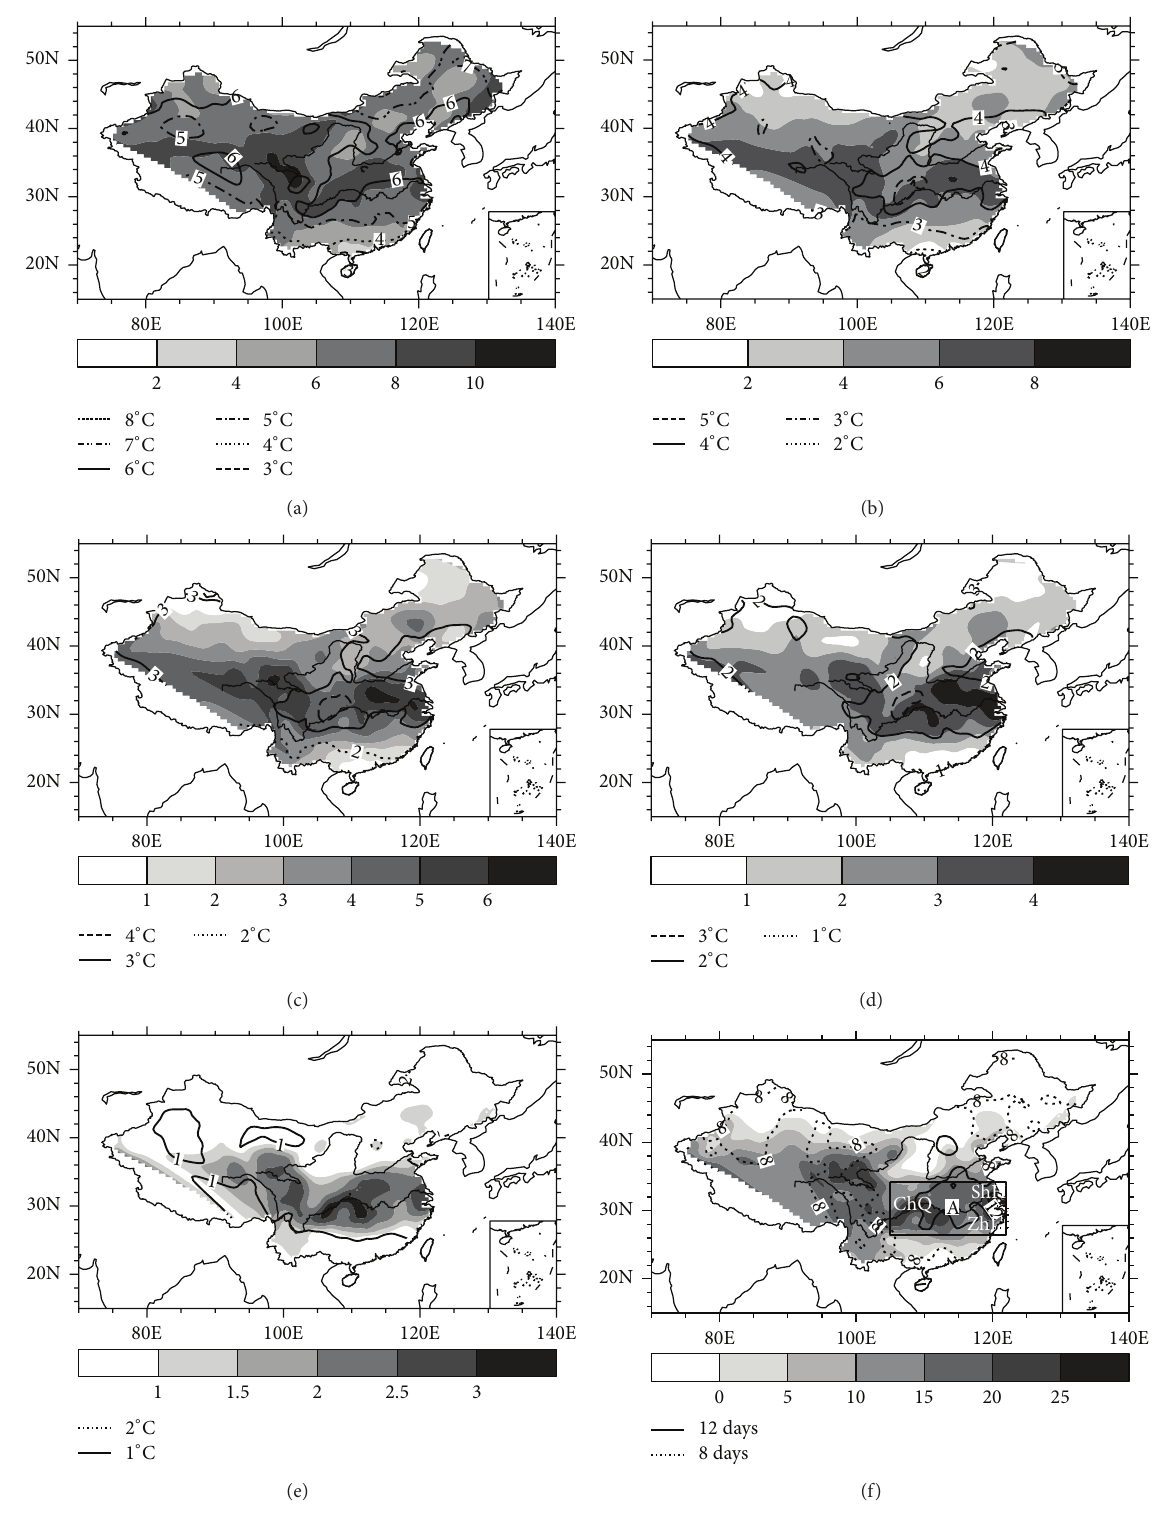
Figure 1: The distribution of the highest value of DMT anomalies ( ∘ C) running-averaging (a) daily, (b) weekly, (c) biweekly, (d) monthly, and (e) seasonally and in the anomaly of the total HDs (days) in 2013 summer in China (f). The shaded areas denote the highest value of DMT anomaly, and the lines denote the 90th percentile threshold of DMT anomaly for 1961–2013 for the corresponding time scales. The rectangle (26.4 ∘ N–34.2 ∘ N, 105 ∘ E–122 ∘ E) in Figure 1(f) indicates region A. “ChQ,” “ShH,” and “ZhJ” in (f) indicate the geographical location of Chongqing, Shanghai, and Zhejiang